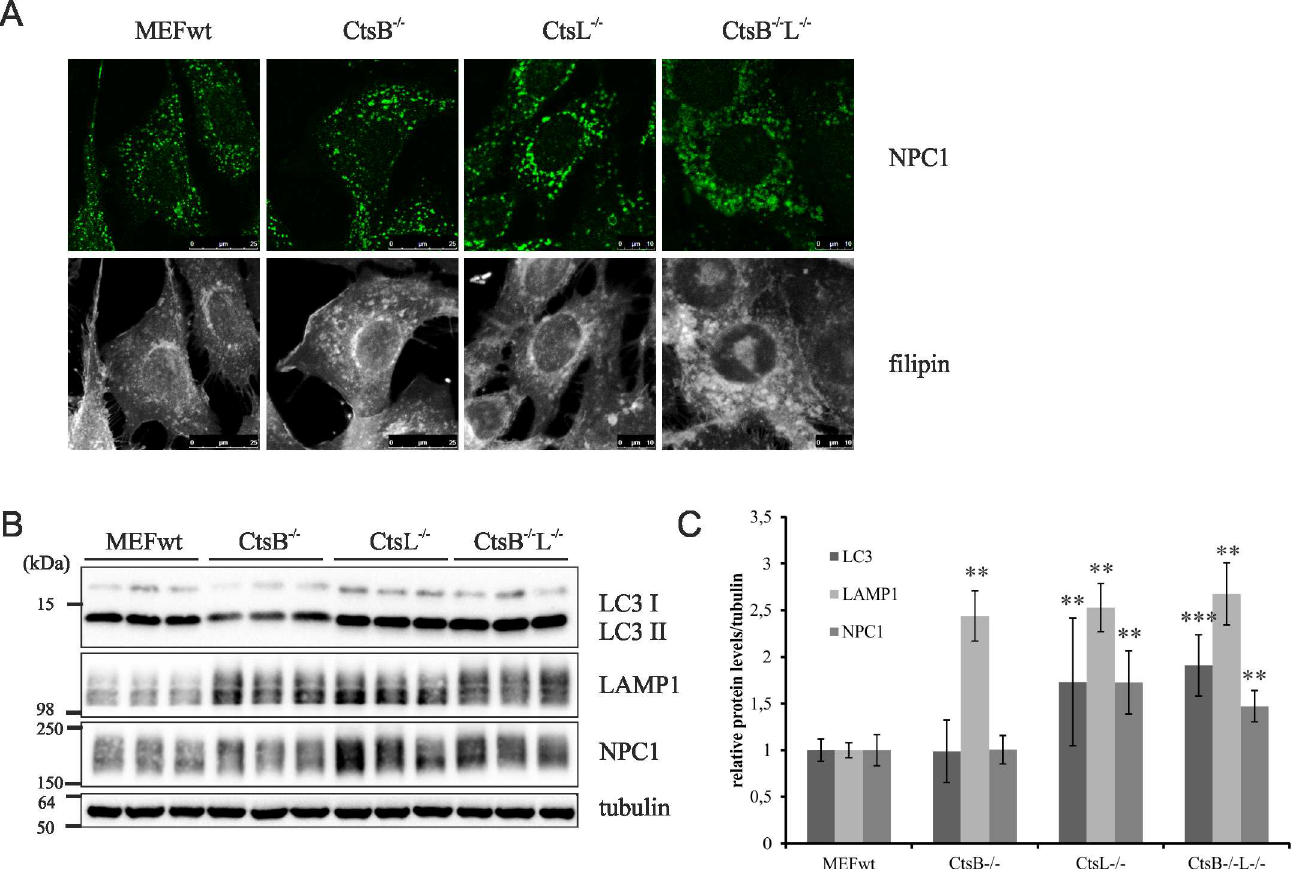
Fig 4. Cathepsin B/L genetic depletion in MEF cells causes accumulation of cholesterol and lysosomal proteins. (A) Confocal microscopy of CtsB KO, CtsL KO and CtsB/L doubleKO MEFs. Cholesterol (filipin staining, white) and NPC1 (green). (B) Western blot analysisof CtsB KO, CtsL KO and CtsB/L doubleKO MEFs using LC3, LAMP1 and NPC1 antibody. α -Tubulinwas used as a loadingcontrol. (C) Quantificationof Western blot results of the 3 independent experiments was performed by ImageJ. Student t-test was used for statistical analysis. Error bars present the mean ± standarddeviation( ** p < 0.01, *** p <